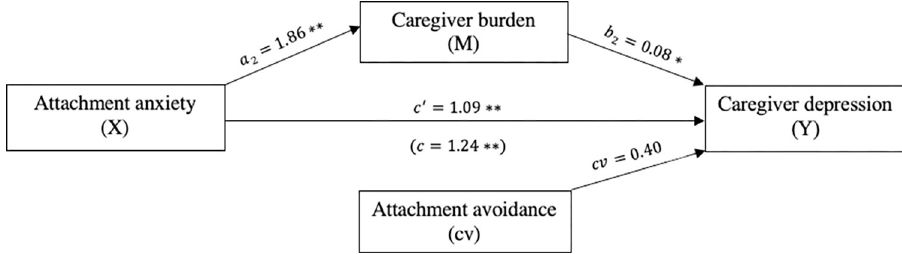
Fig 4. The mediating effect of caregiver burden in the relationship between attachment anxiety and caregiver depression. � p < 0.05, �� p < 0.001, cv = covariate.